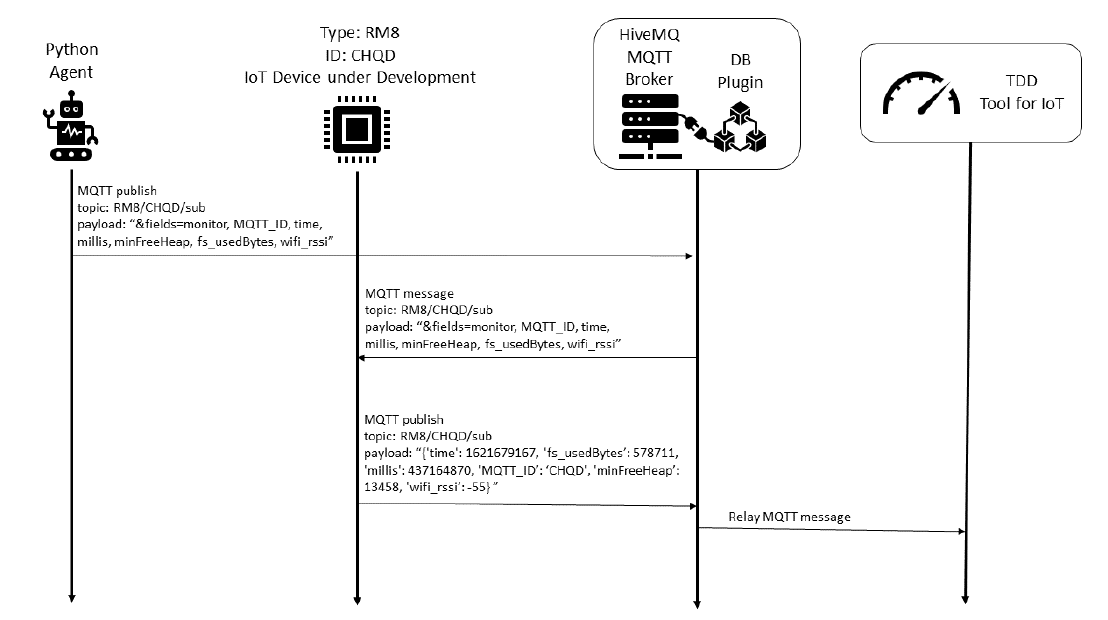
Figure 14. TDD procedure for IoT device under development (smart home scenario).